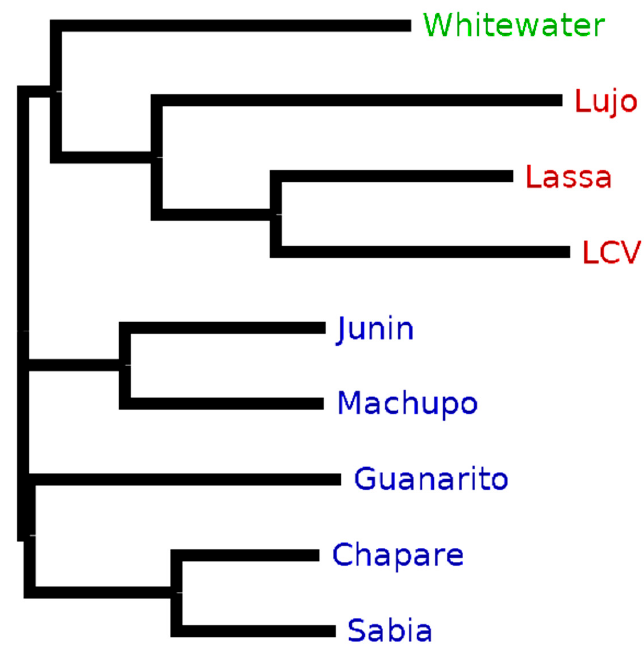
Figure 5. Phylogenetic tree of the pre-glycoprotein polyprotein GP complex (GLYC) of nine arenaviruses. The Whitewater strain is the only New World clade A / rec arenavirus (green). Lujo (LUJV), Lassa (LASV), and Lymphocytic choriomeningitis (LCV) are geographical Old World arenaviruses (red). Junin (JUNV), Machupo (MACV), Guanarito (GTOV), Chapare (CHAV), and Sabia (SABV) are members of the New World arenaviruses clade B (blue). The neighbor-joining tree without distance corrections was created using CLUSTAL Omega [34] for the multiple sequence alignment and the tree visualization software FigTree (http: // tree.bio.ed.ac.uk / software / figtree / ).